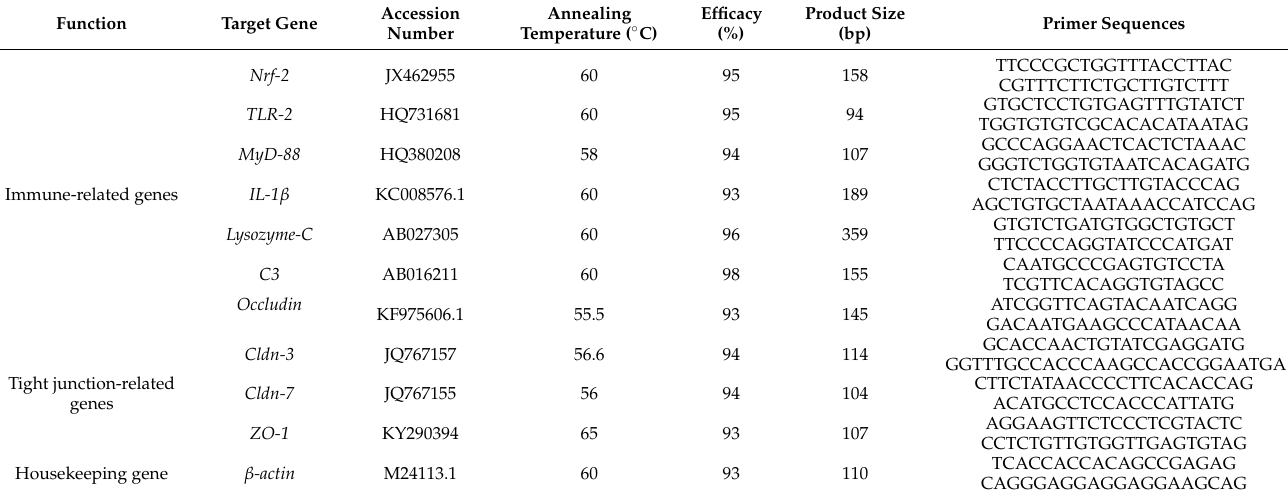
Table 2. Primers used for real-time PCR